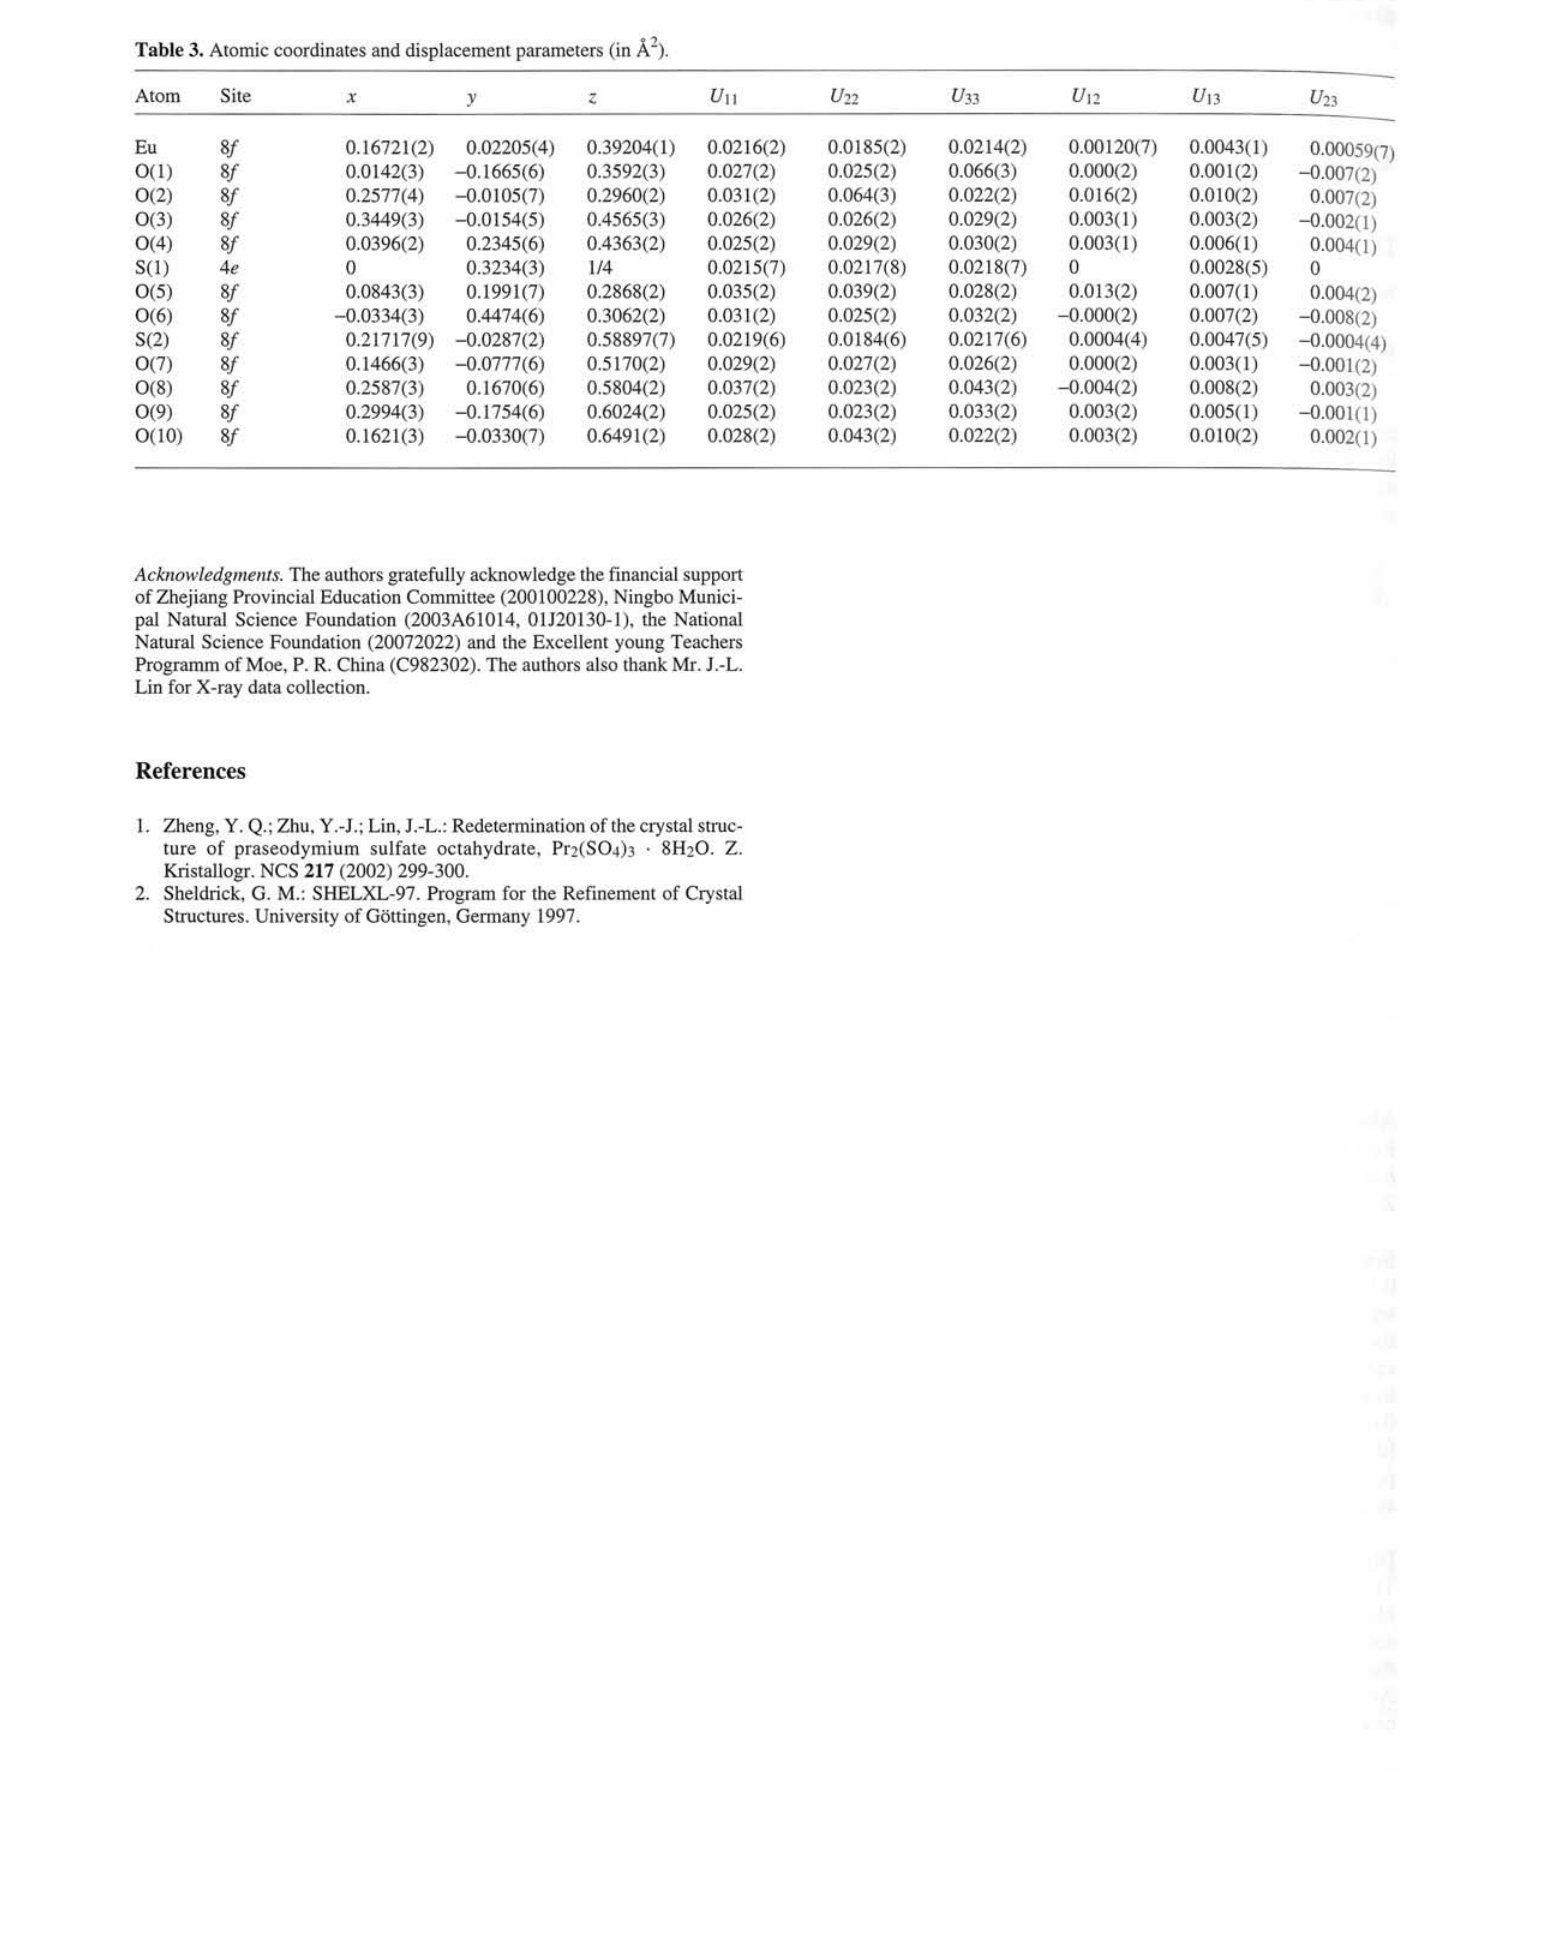
Table 3. Atomic coordinates and displacement parameters (in Â 2